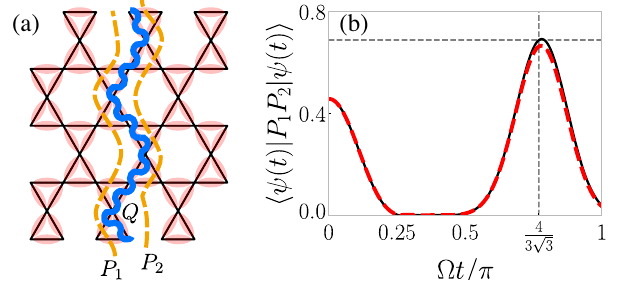
FIG. 12. Measuring the off-diagonal string operator through a quench protocol. (a) The vertical direction is periodic on the cylinder. The off-diagonal string Q (blue wiggly line) can be obtained by measuring the diagonal string P 1 P 2 (orange dashed lines) after a time evolution with a nearest-neighbor Rydberg ffiffiffi p 3 blockade Hamiltonian to time Ω t ¼ 4 π = ð 3 Þ [see Eq. (6)]. (b) Starting from the spin liquid ground state of the Rydberg Hamiltonian with R b ¼ 3 . 8 a and δ = Ω ¼ 5 . 3 on a ruby lattice with aspect ratio ρ ¼ 3 (see Fig. 10), we measure h P 1 P 2 i after time evolving with either the nearest-neighbor Rydberg blockade model (solid black line) or the ground state Hamiltonian quenched to R b ¼ 2 (red dashed line). The horizontal gray dashed line denotes the ground state value for h Q i